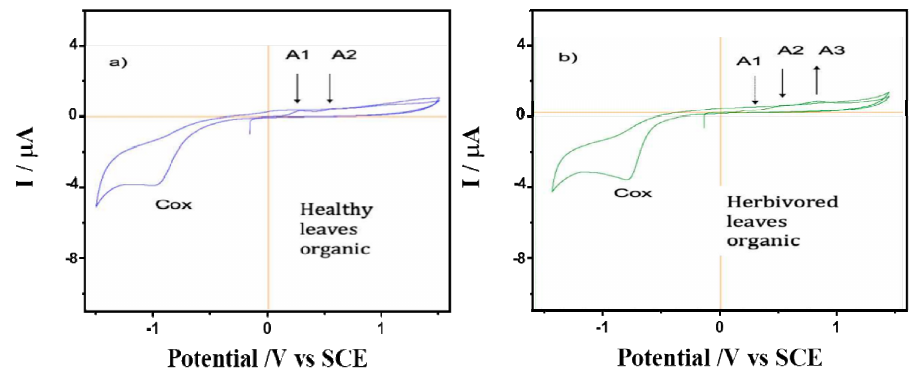
Figure 3. Cyclic voltammograms of films from ( a ) healthy and ( b ) predated leaves of A. cathartica on glassy carbon electrode in contact with air-saturated 0.10 M phosphate buffer at pH 7.0. Scan rate 10 mV.s − 1 .